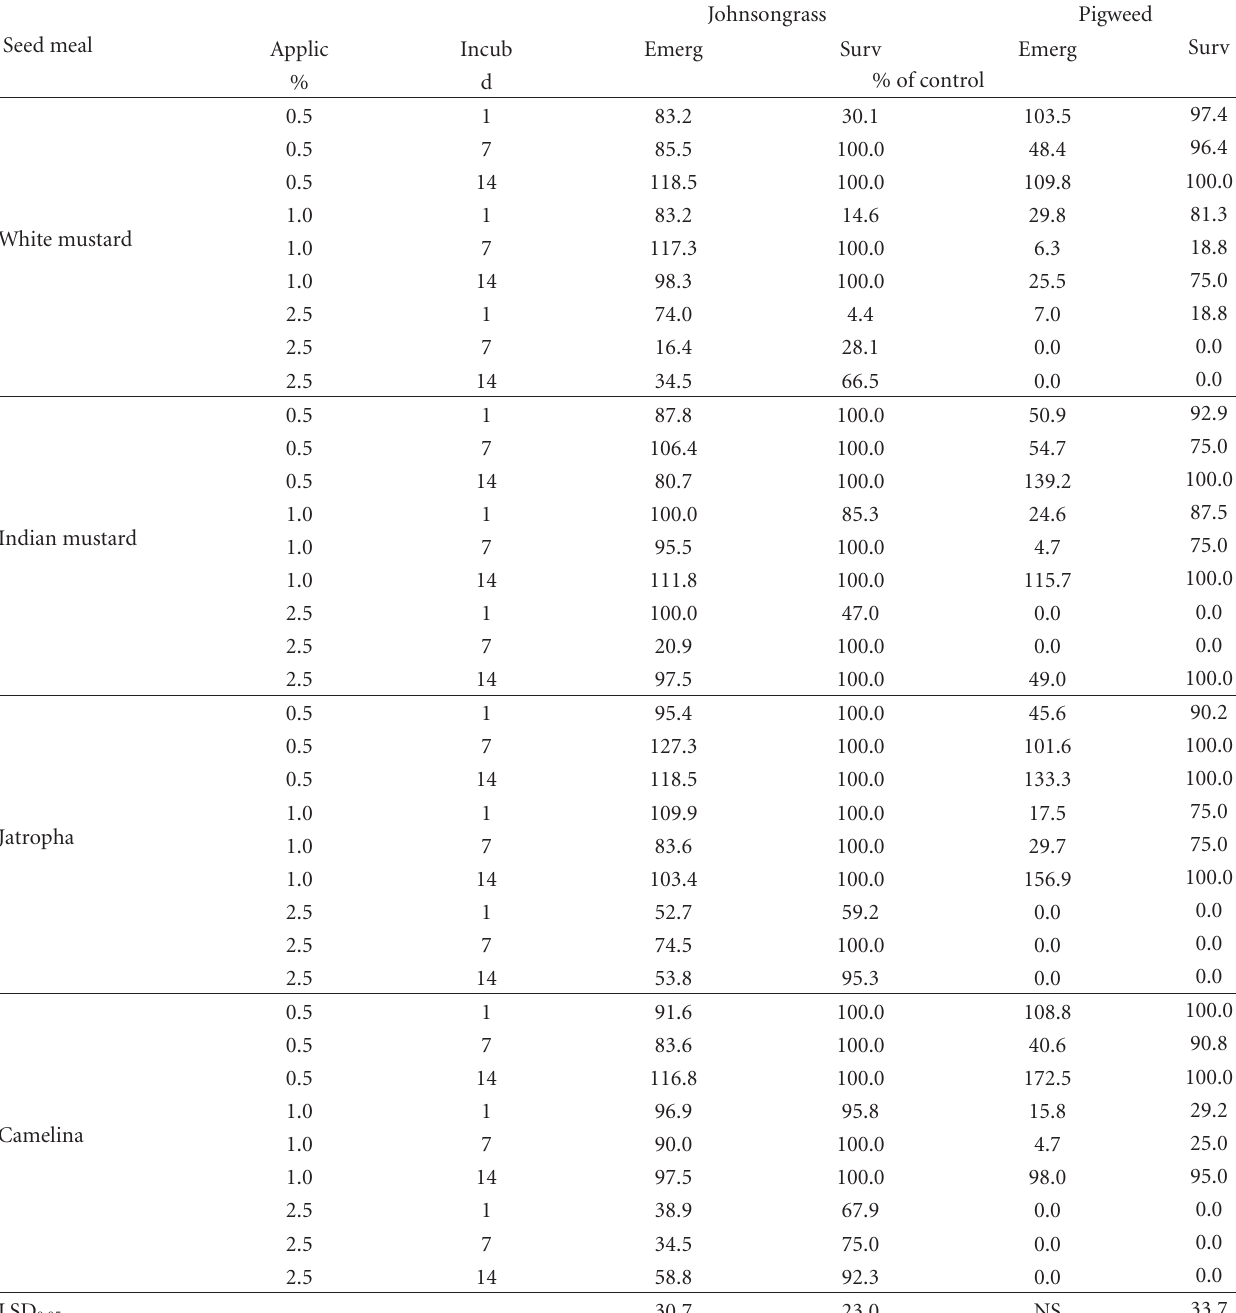
Table 3: Three-way interaction of “seed meal source, application rate (applic) and incubation time (incub)” on johnsongrass and pigweed emergence (emerg) and survival (surv). Incubation refers to the length of time in days after SM was added to soil and prior to seeding. Data are the means (four replications) within weed species ( n =